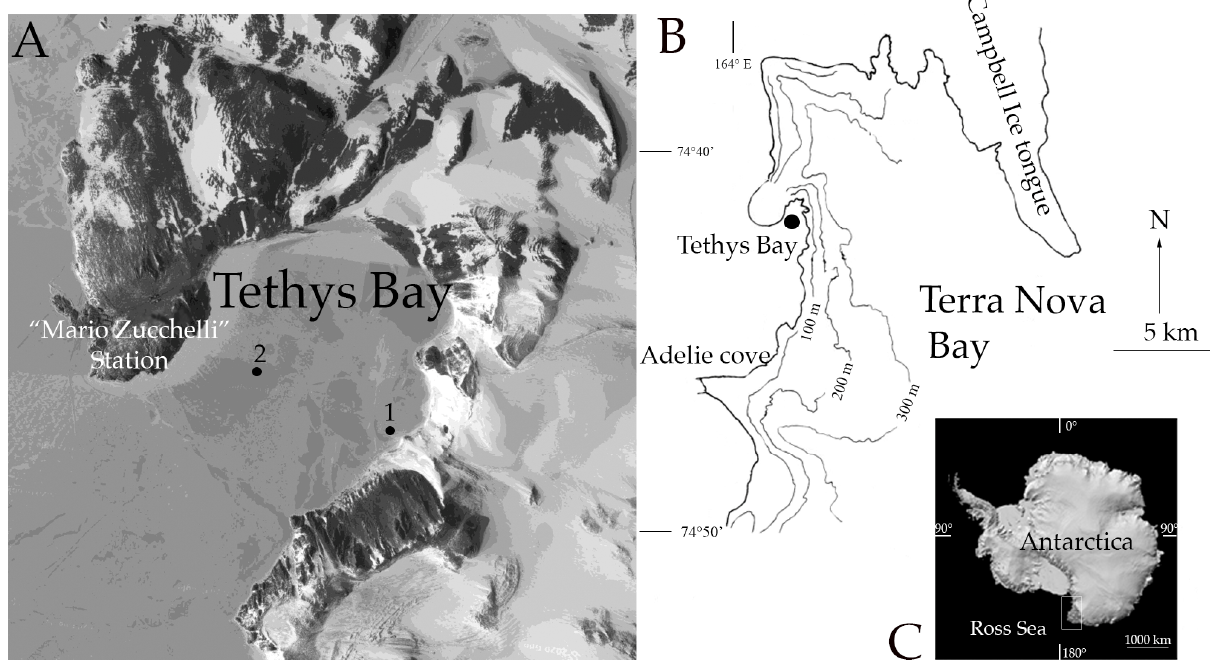
Figure 1. Study area and collection sites. ( A ) Zoomed view of Tethys Bay, (within Terra Nova Bay, Ross Sea), with the positions of the collection sites (1, 2) (modified from Google Earth); ( B ) Map of Terra Nova Bay; ( C ) Antarctica (modified from Geopolar geospatial Centre).